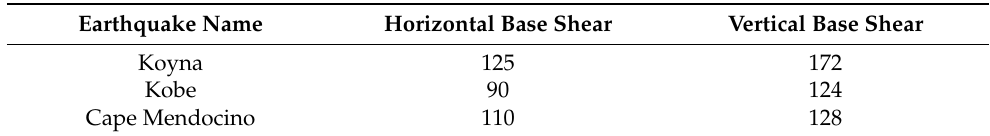
Table 4. Maximum base shear of the tanks (kN).